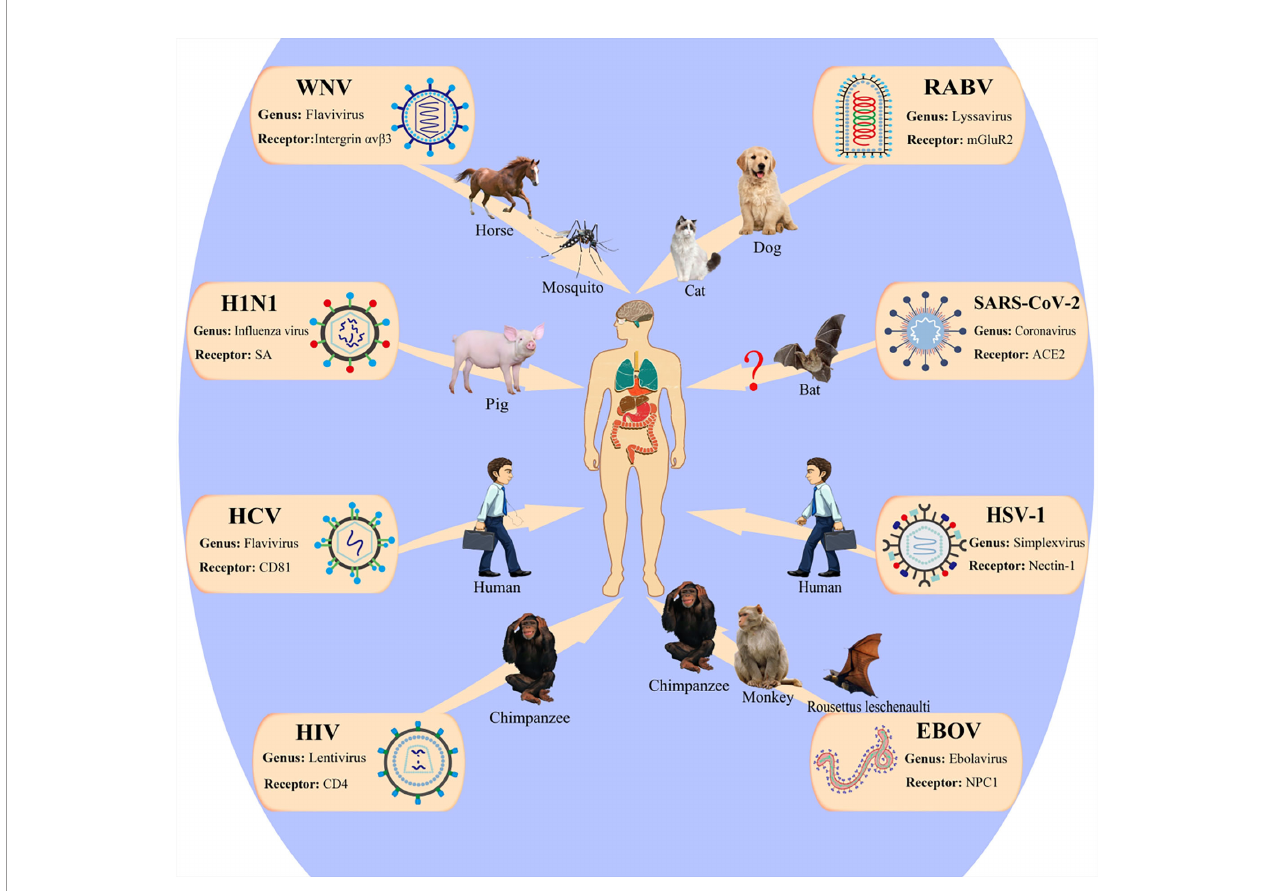
FIGURE 4 | Patterns of viruses infect the human host. WNV, West Nile virus; HCV, hepatitis C virus; RABV, rabies virus; mGluR2, metabotropic glutamate receptor 2; ACE2, angiotensin-converting enzyme 2; EBOV, Ebola virus; NPC, Niemann – Pick type C; HSV, herpes simplex viruses; HIV-1, human immunode fi ciency virus 1. This fi gure is adapted from reference